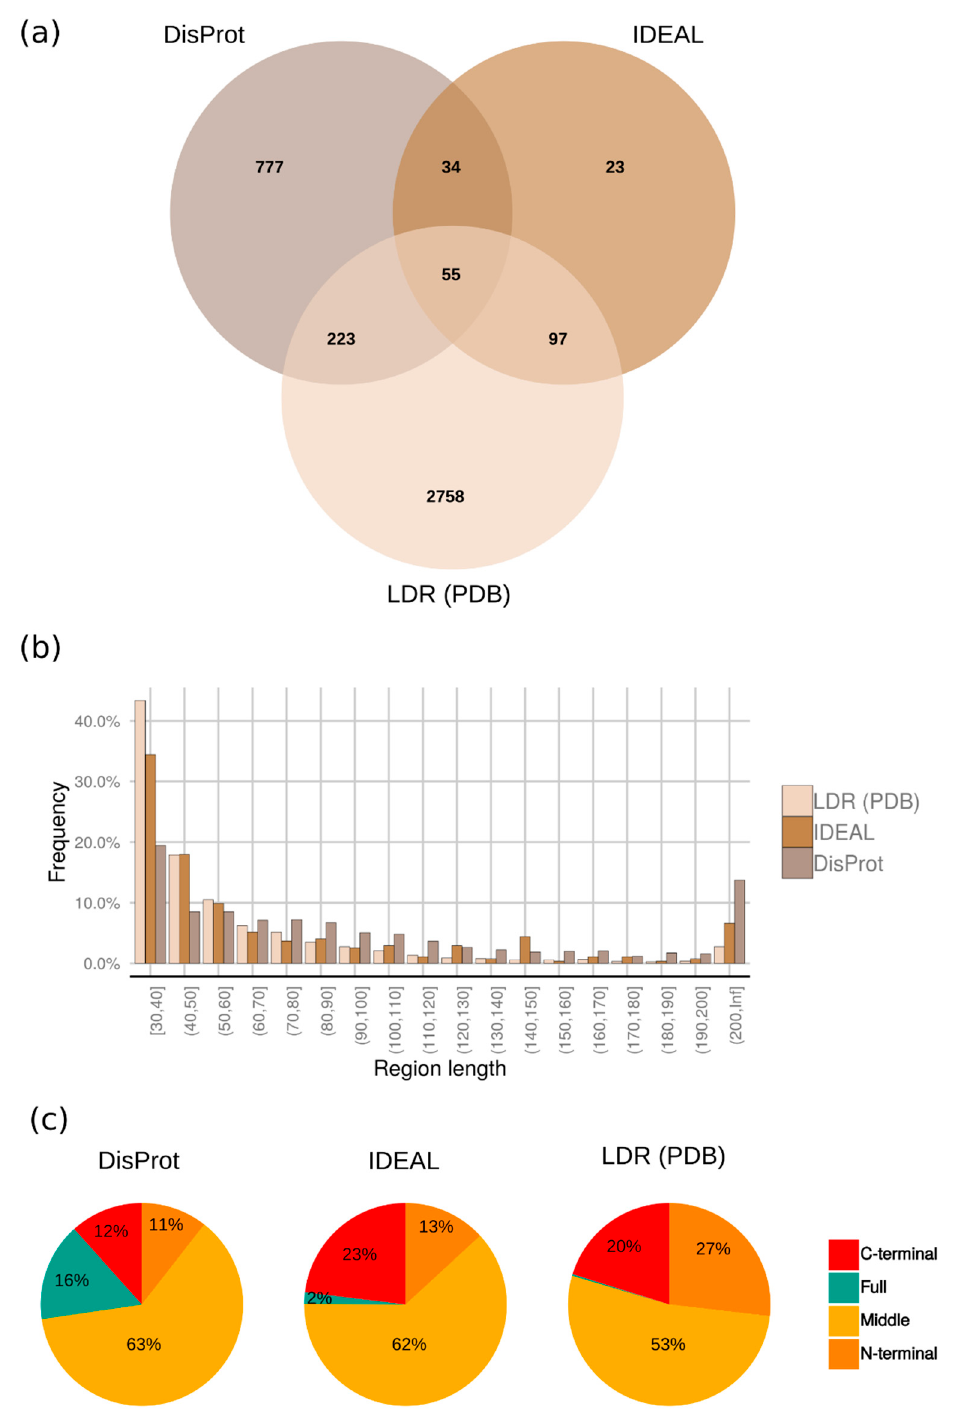
Figure 4. Comparison with Long Disordered Regions (LDRs) from DisProt and IDEAL. ( a ) Venn diagram showing the overlap between our LDR dataset from PDB, DisProt, and IDEAL. Only proteins with LDR regions (at least 30 residues) were considered for IDEAL and DisProt databases. ( b ) Length distribution of the long-disordered regions found in DisProt, IDEAL and LDR (PDB) dataset. The data is grouped by bins of ten residues. ( c ) Fraction of LDRs which fall in the N- or C-terminus, middle of the protein or cover the entire sequence (full). Tails (N- and C-) refers to LDRs at the ends (20% of the total residues) of the full protein length.